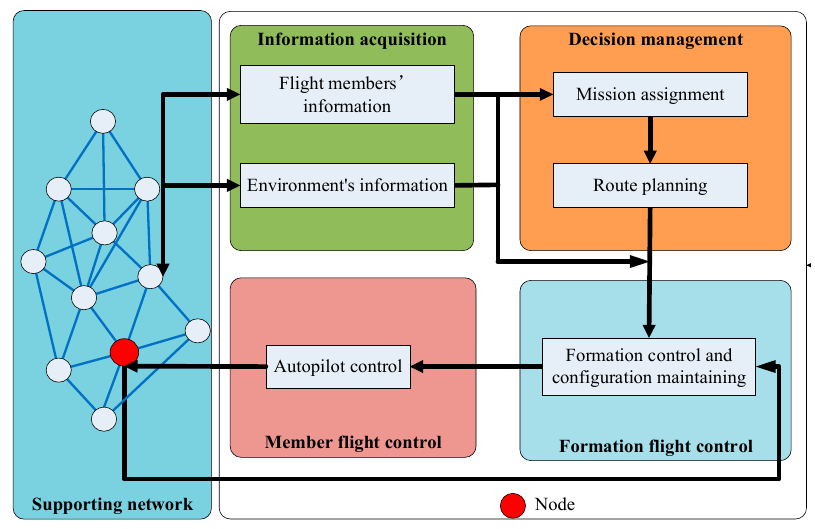
Figure 5. Simulation framework.